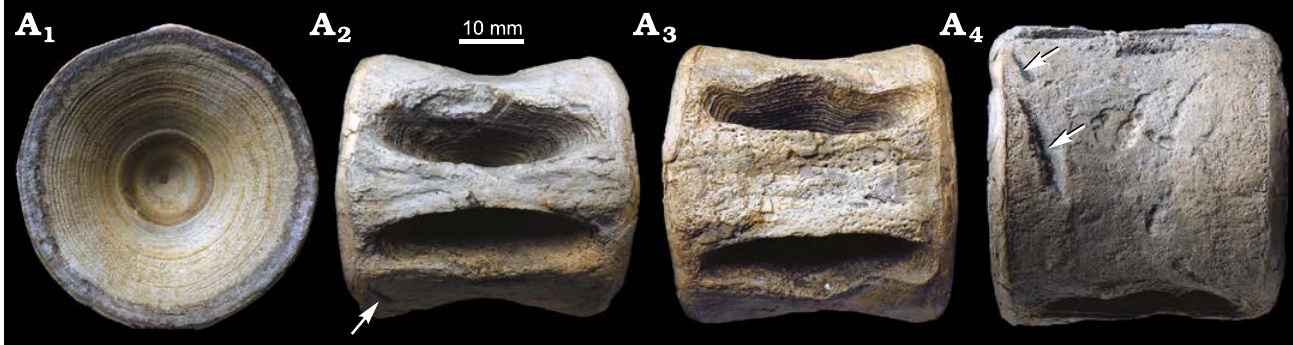
Fig. 5. Centrum of a carcharhinid shark, cf. Galeocerdo cuvier (Péron and Lesueur, 1822) (CMM-V-10336), from the Neogene of Aurora, NC, USA. Centrum in articular (A 1 ), dorsal (A 2 ), ventral (A 3 ), and lateral (A 4 ) views. Sub-parallel bite traces are indicated by